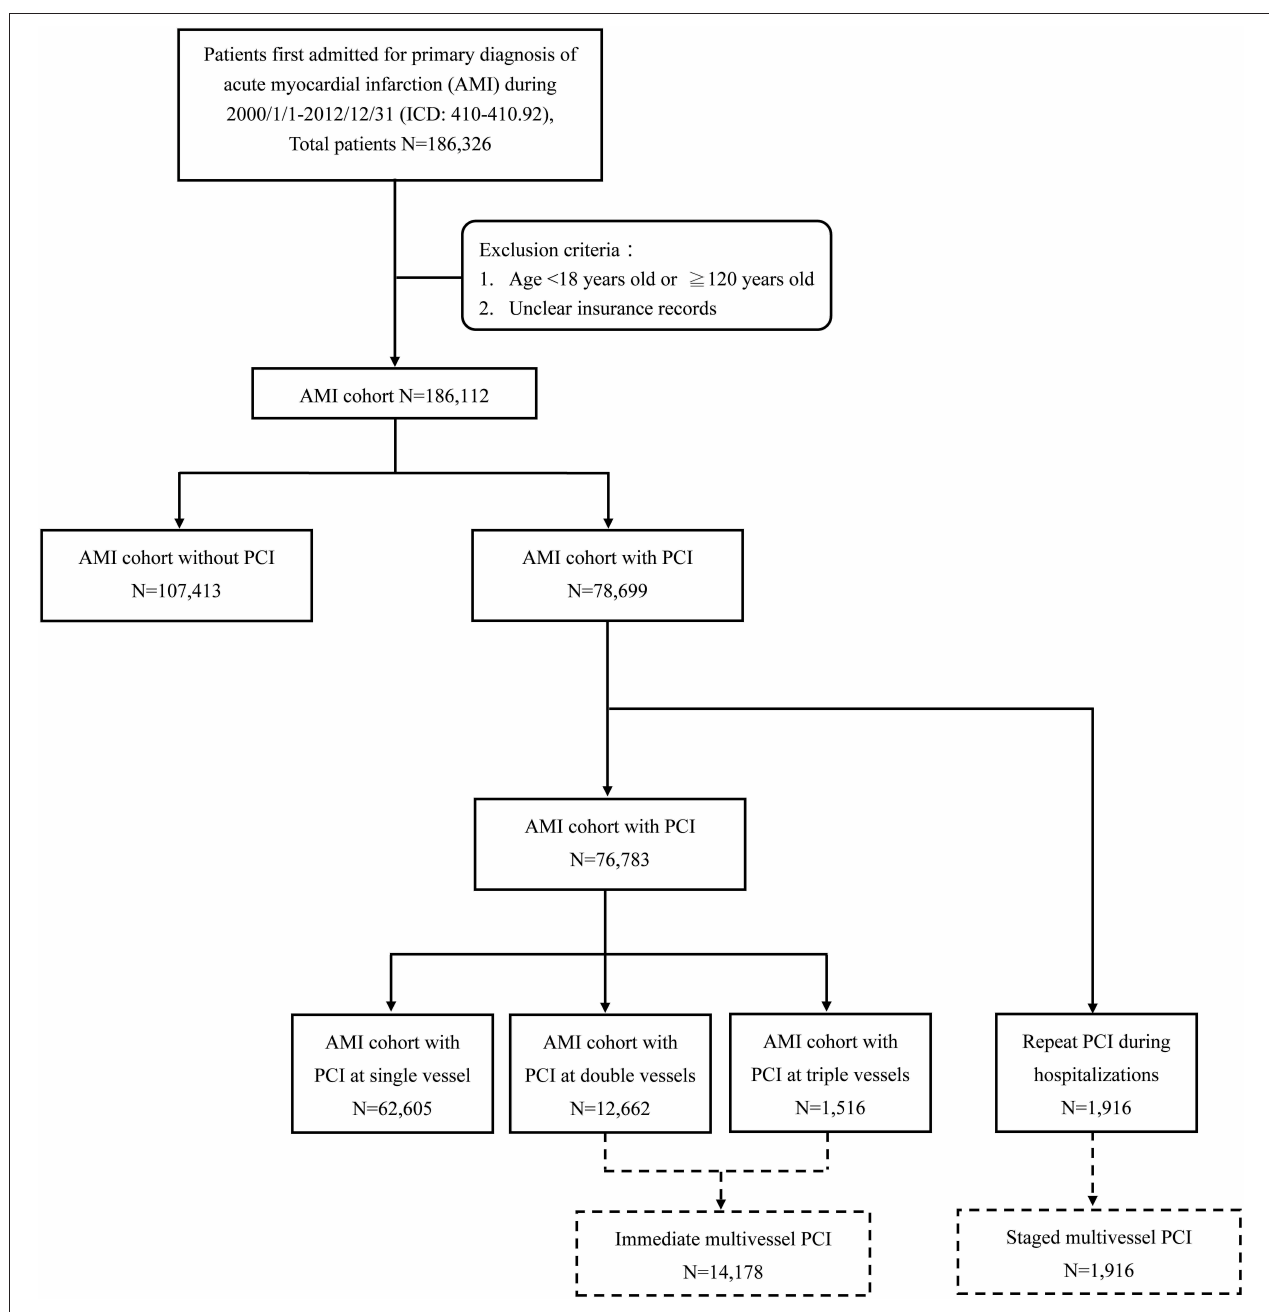
FIGURE 1 | Flowchart of case selection from the Taiwan National Health Insurance Research Database. AMI, acute myocardial infarction; PCI, percutaneous coronary